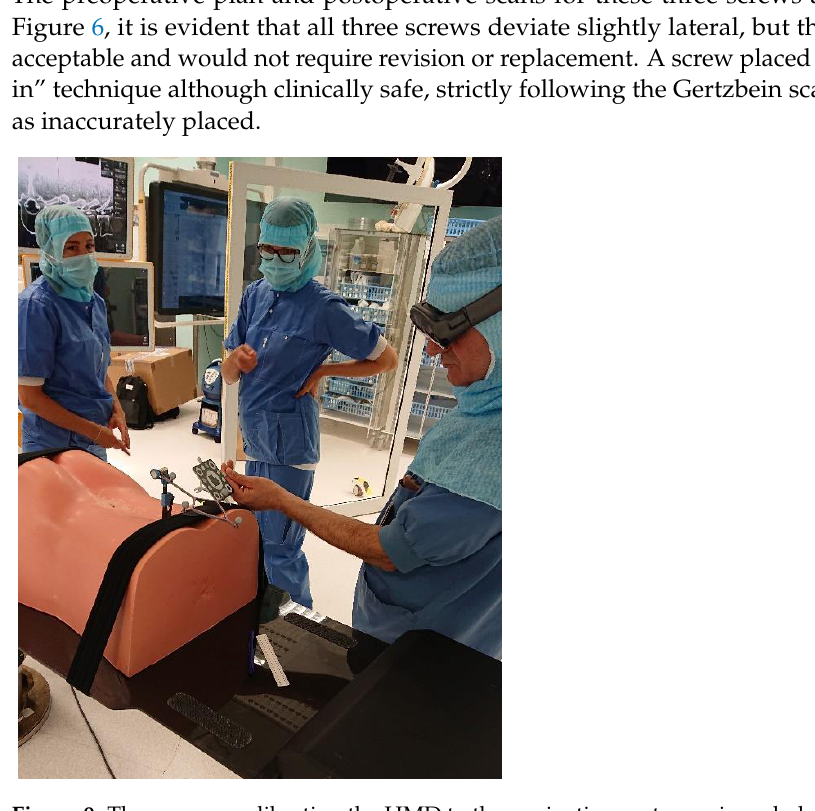
94% using Hololens [28].